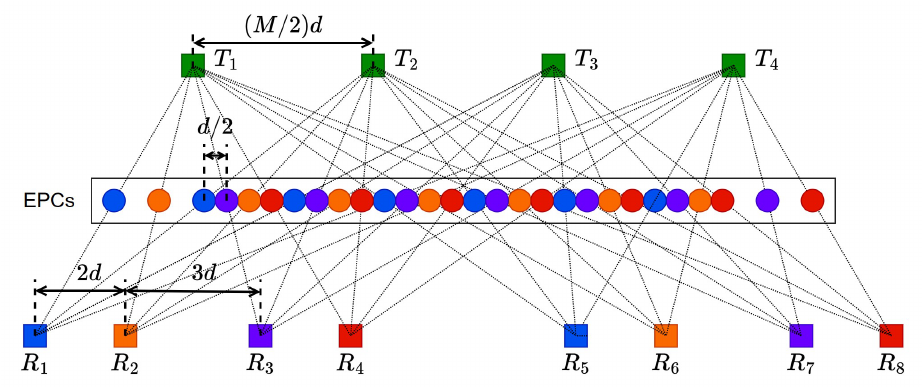
Figure 5. The illustration of innovative array